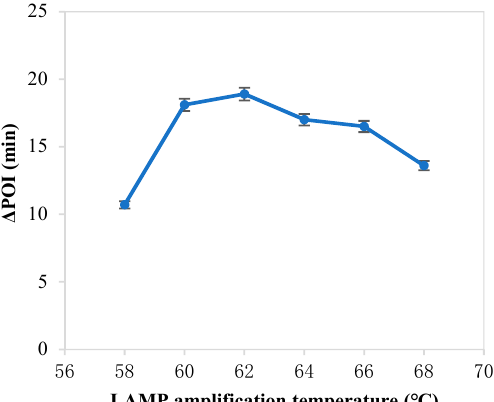
Figure 3. The effect of the LAMP amplification temperature on the RC-LAMP assay. The graph shows the ∆ POI value vs. the LAMP amplification temperature. Experimental conditions: